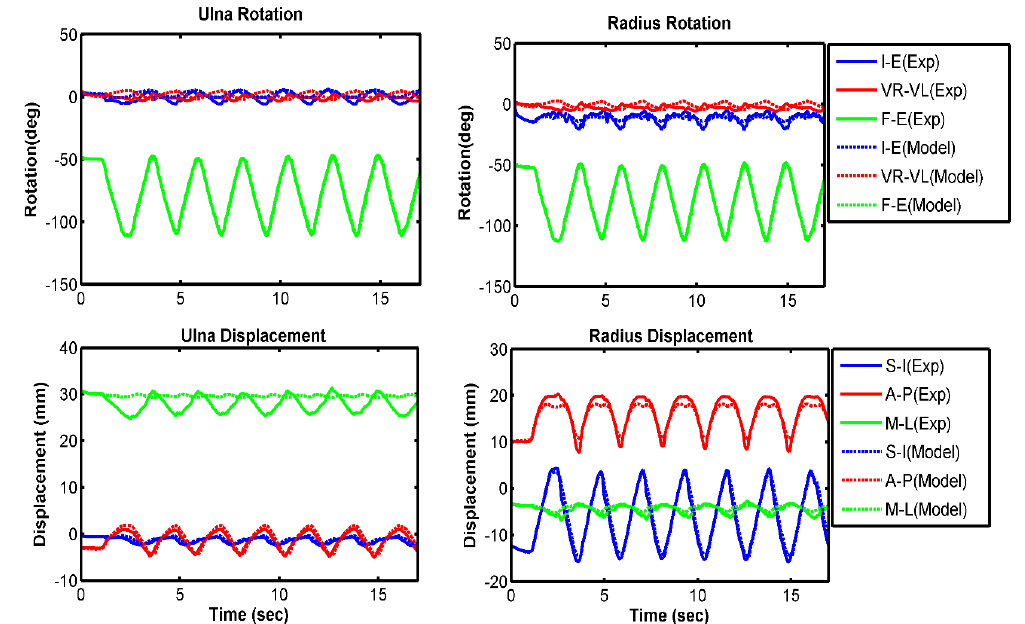
Figure 5. Comparison of bone kinematics between experiment and model prediction for 60 deg/s trial. Increasing trend of the graph indicates more internal rotation for I–E, more valgus rotation for VR–VL, and more extension for F–E. Similarly, it indicates more superior translation for S–I, more anterior translation for A–P, and more medial translation for M–L. Decreasing trend of the graph indicates the opposite.